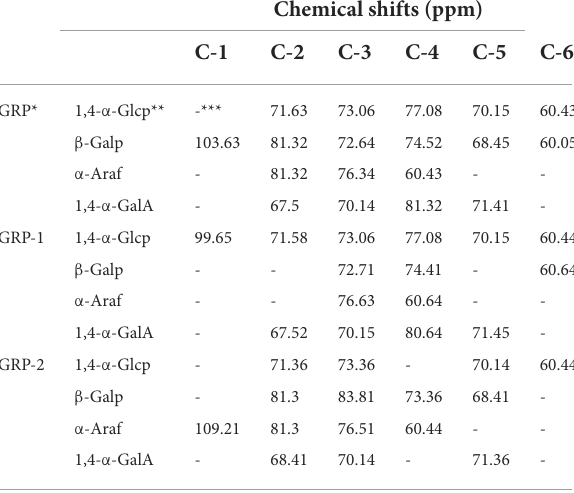
TABLE 2 The signals of chemical shifts in 13 C NMR spectra of GRP, GRP-1 and